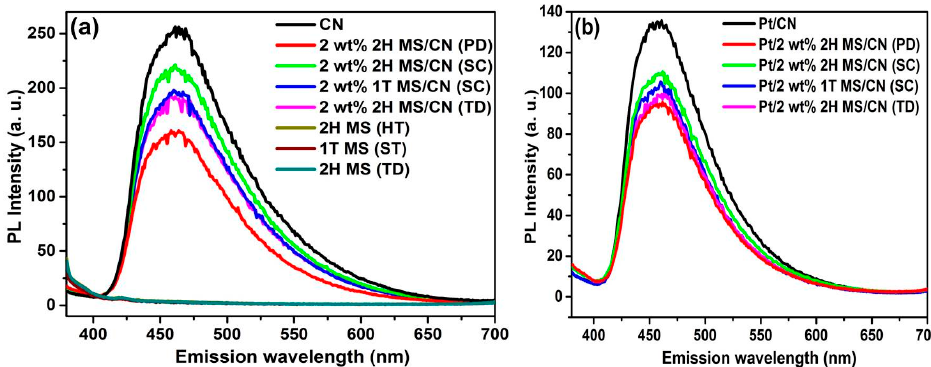
Figure 7. Photoluminescence spectra of ( a ) the as-synthesized catalysts; ( b ) recovered Pt containing catalysts after 6 h under UV-vis light irradiation.